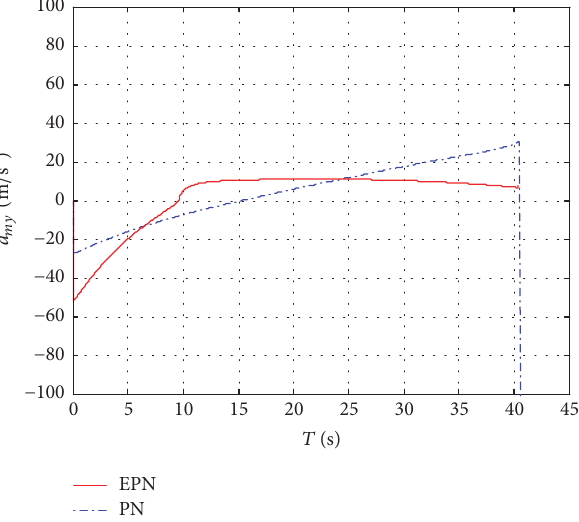
Figure 7: Time history of normal acceleration.